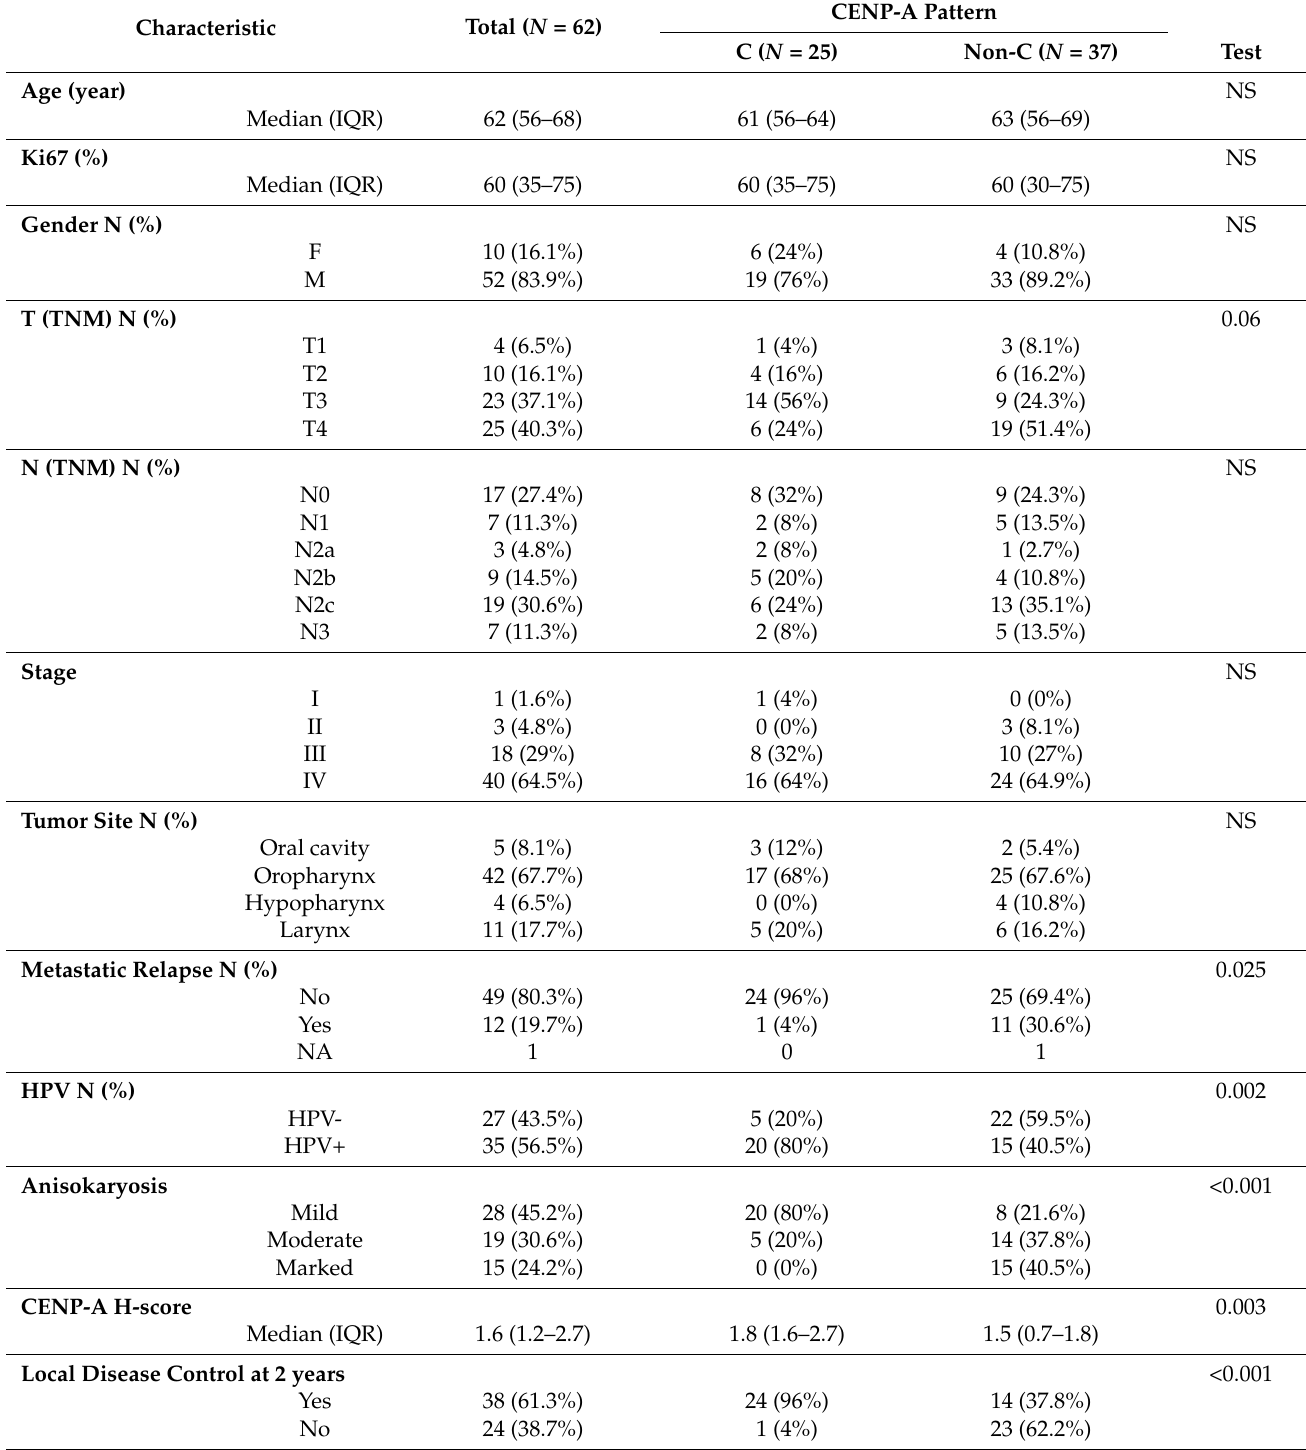
Table 1. Correlations between CENP-A pattern-C and non-C and patients and tumor characteristics.